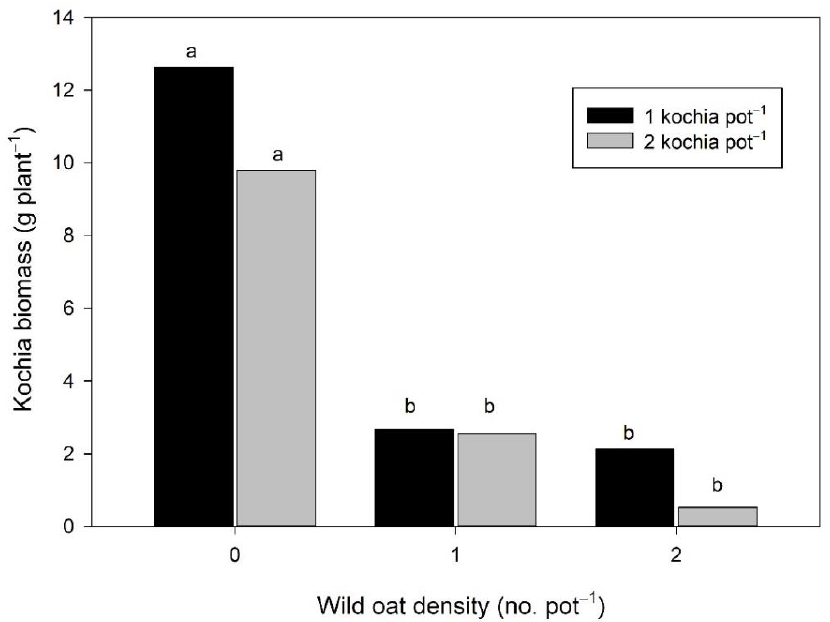
Figure 4. Kochia ( Kochia scoparia ) biomass in response to wild oat ( Avena fatua ) and kochia interference for the second experimental run in Saskatoon, SK in 2019. In the second experimental run, there was an interaction between kochia and wild oat densities. Values are least square means. Different letter groupings indicate a significant difference using Tukey’s honest significance test ( α = 0.05). Plants were grown in 13 cm diameter round pots filled with potting soil. Biomass was harvested 81 days after trial initiation.